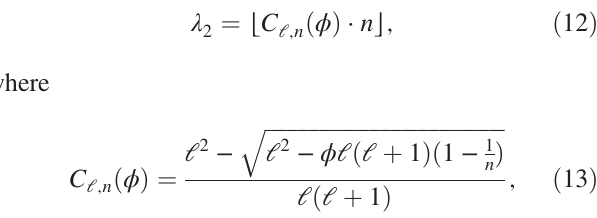
FIG. 3. UCM and MCC networks of size n ¼ 20 for the maximization of smallest nonzero Laplacian eigenvalue λ 2 . For a given link density ϕ , the orange dot indicates λ 2 for MCC networks. A UCM network, when possible for that value of ϕ , is indicated by a green dot. As ϕ increases, the eigenvalue λ 2 experiences discrete jumps, corresponding to sudden changes in the structure of the network. The changes in the link configuration of the network ’ s complement, as well as the associated jumps in the size of their largest clusters, are illustrated in the circles. At ϕ values just above and below the jumps, the complement has m c ¼ M ð n; k n;m Þ links and m c ¼ c M ð n; k 1 links, n;m c Þ þ